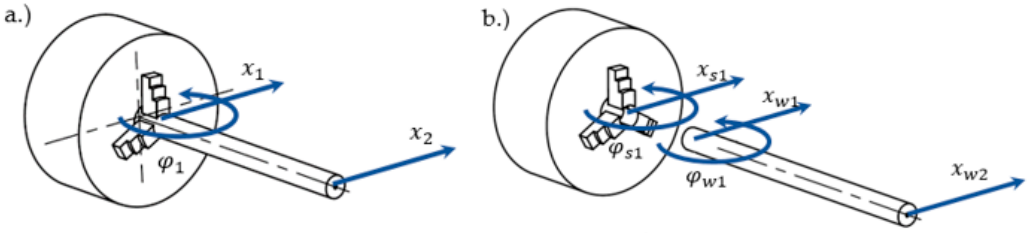
Figure 13. Receptance coupling system: ( a ) components, ( b ) coupled system.